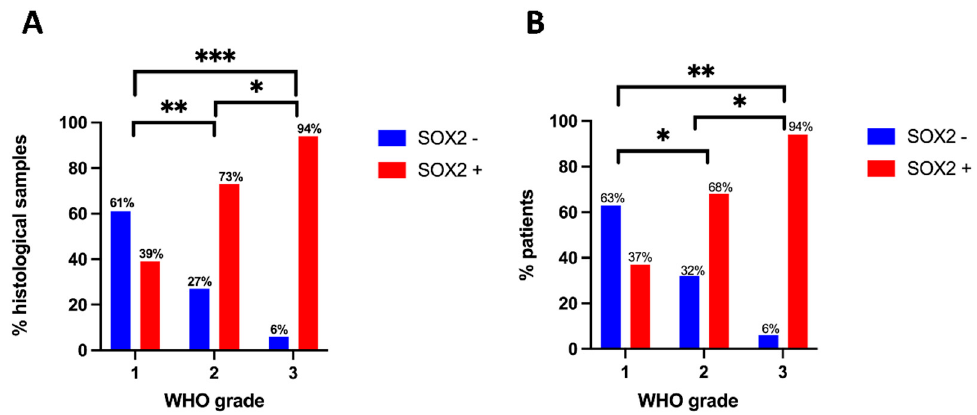
Figure 2. Correlation between SOX ICH status and meningioma grade. (A), Histogram showing analysis performed on all available samples. SOX2-positive cases are significantly higher among WHO grade 3 tumors than among grade 1 ( p < 0.0001, Fisher ′ s exact test) and grade 2 meningiomas ( p = 0.0189, Fisher ′ s exact test); moreover, SOX2-positive cases are higher in grade 2 than in grade 1 tumors ( p = 0.0069, Fisher ′ s exact test). ( B ), Histogram showing analysis performed on samples obtained at the first diagnosis in the whole series. Similar to the analysis shown in ( A ), we found a significantly higher percentage of SOX2-positive cases in grade 3 meningioma compared to grade 1 and 2, and in grade 2 compared to grade 1 meningioma ( p = 0.0003, p = 0.0499 and p = 0.0141, respectively; Fisher ′ s exact test). *p <0.05; ** p <0.01; *** p <0.0001.